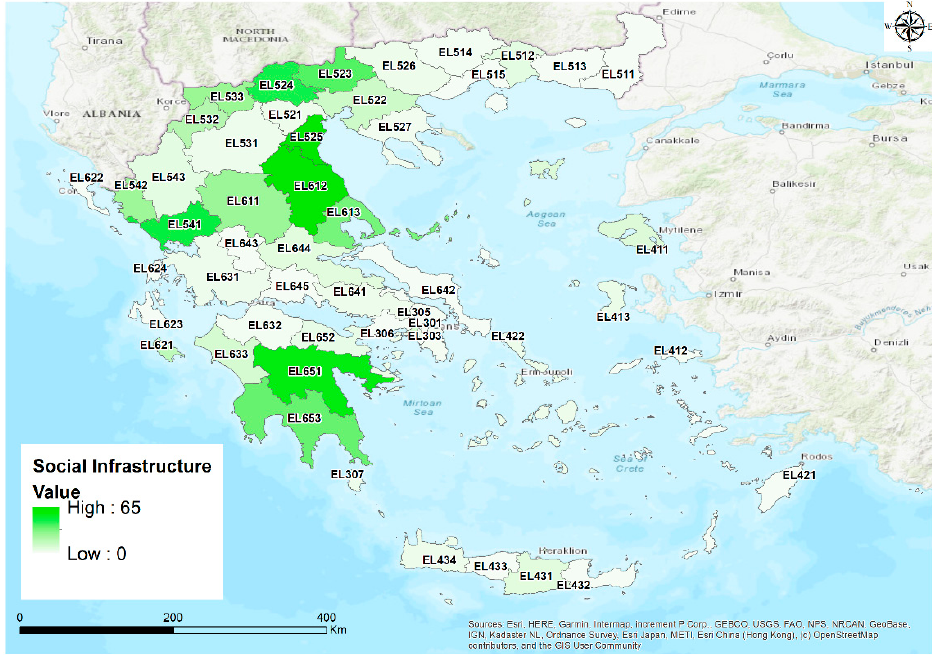
Figure 12. Spatial distribution of the ratio of social infrastructure in flood zones per NUTS 3.